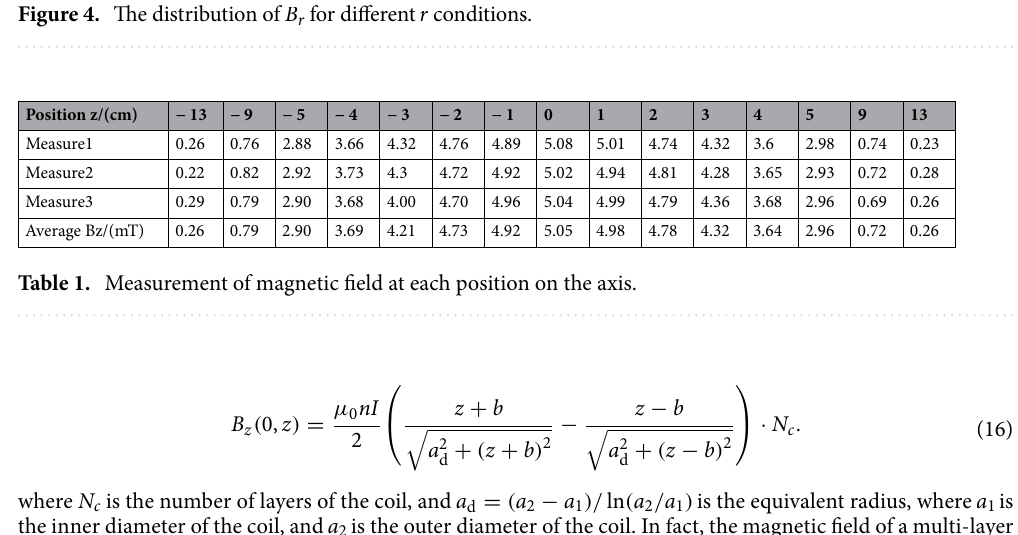
Figure 4. The distribution of B r for different r conditions.